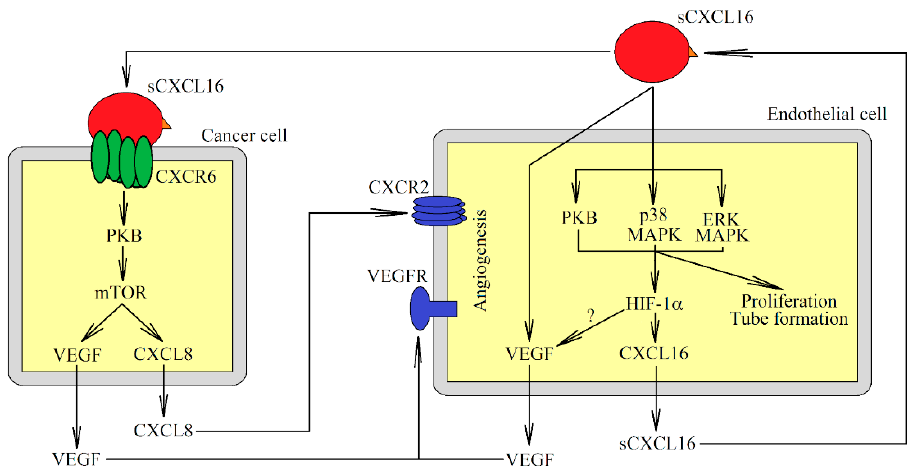
Figure 3. The role of sCXCL16 in angiogenesis. By activating CXCR6, sCXCL16 increases the expression of pro-angiogenic factors such as VEGF and CXCL8/IL-8 in the tumor cell. Also, sCXCL16 acts on endothelial cells and increases VEGF expression and proliferation, and can cause tube formation of these cells. sCXCL16 also increases the level of HIF-1 α protein in endothelial cells, which leads to an increase in the expression of CXCL16 itself.